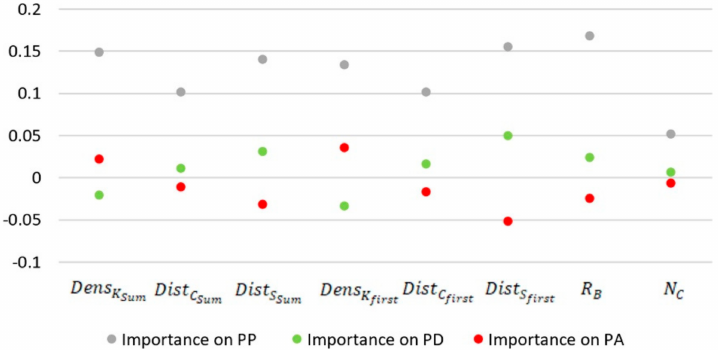
Figure 7. The importance of measures on predicting the adjacency types: PP as prediction process, PD as predicting the detached buildings, and PA as predicting the attached